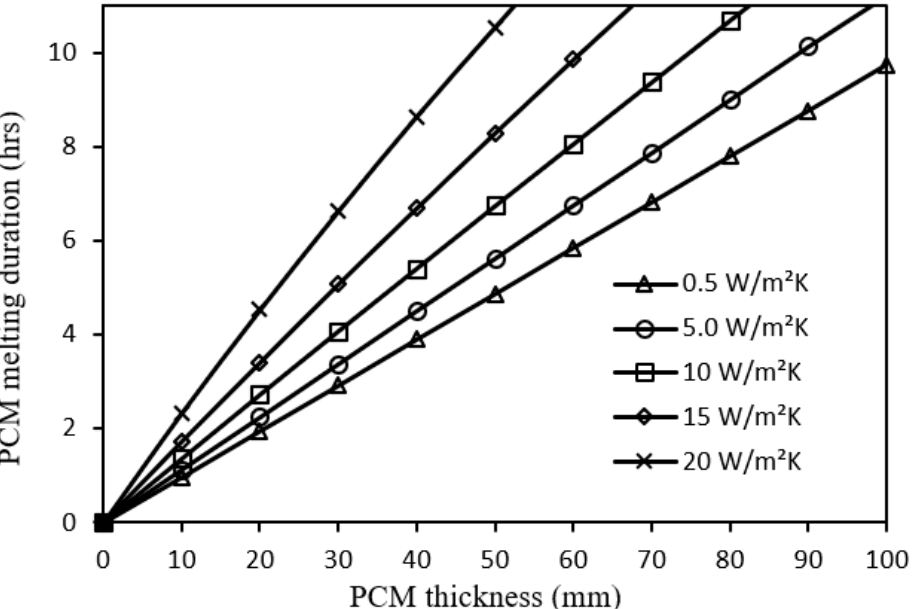
Figure 12. Impact of PCM thickness on PCM melting duration for different metal foam convective heat transfer coefficients.